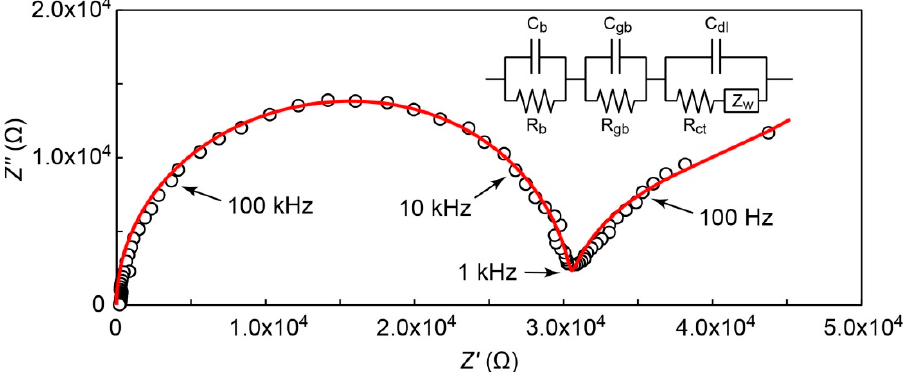
Figure 6. Nyquist spectrum (open circles) of as-prepared C 12 im- δ -Mo 8 ( 2 ) at 443 K and simulated spectrum (red line) based on an equivalent electronic circuit in the figure. The parameters obtained by the fitting (see text) are as follows: R b = 1.85 × 10 4 Ω , R gb = 1.2 × 10 4 Ω , R ct = 1.1 × 10 4 Ω , C b = 1.0 × 10 − 8 F, C gb = 6.0 × 10 − 9 F, C dl = 3.0 × 10 − 6 F, σ = 2.2 × 10 4 Ω ·s − 1/2 ( Z w = (1 − (cid:1862))(cid:2026) √(cid:2033)⁄ ).